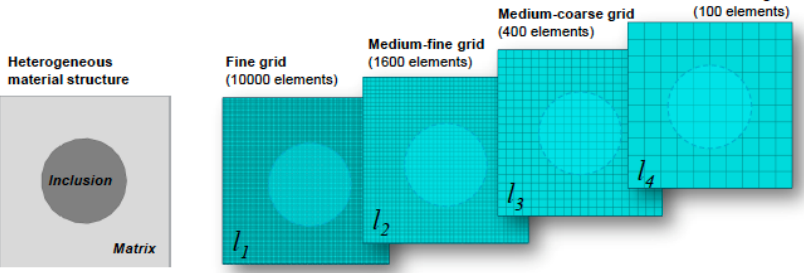
Figure 17. The multigrid method can be implemented for solving multiscale problems in heterogeneous materials. The heterogeneities are mapped onto the different grids (from the finest to the coarsest).